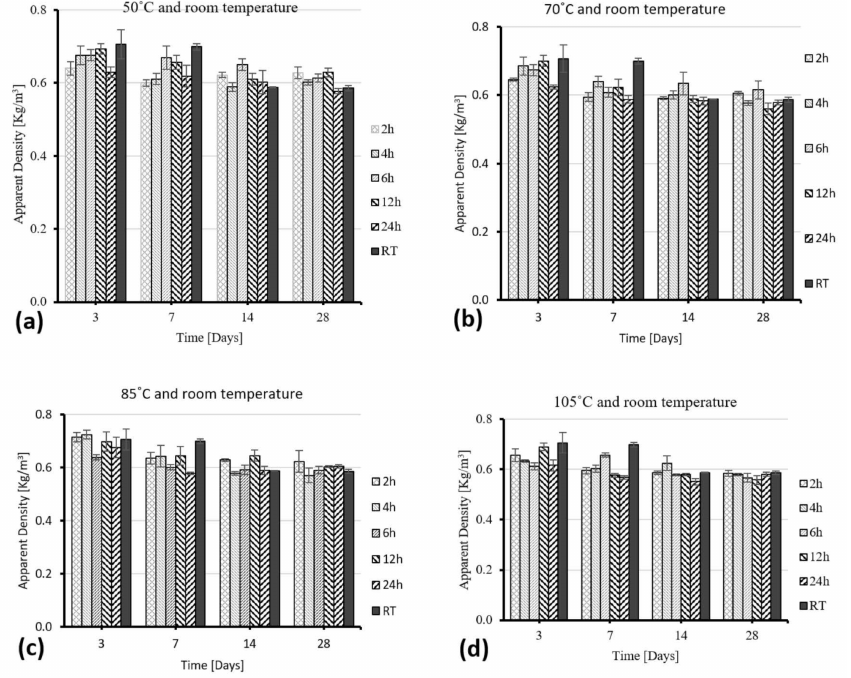
Figure 4. Apparent density of GF at different curing temperatures: ( a ) 50 ◦ C, ( b ) 70 ◦ C, ( c ) 85 ◦ C and ( d ) 105 ◦